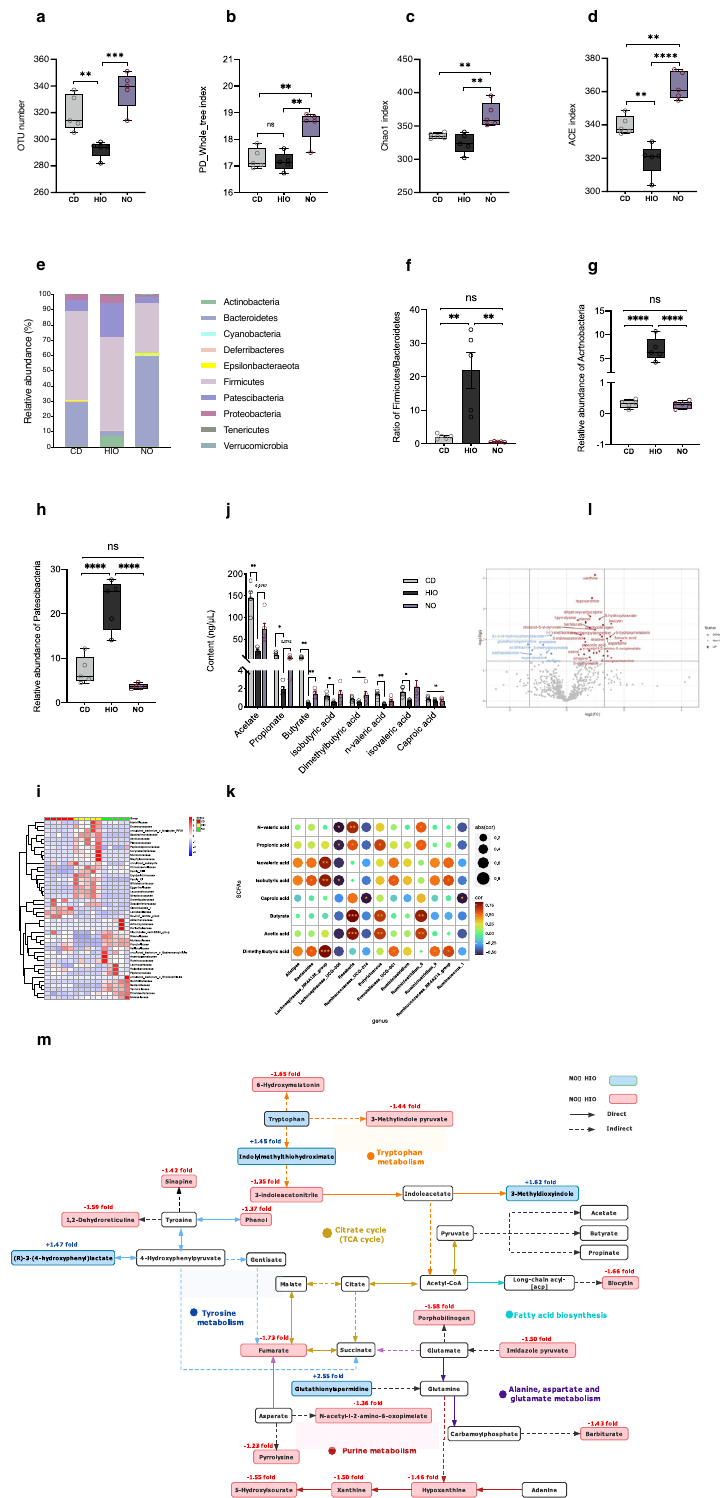
SCFA treatment ameliorates HFD obesity-induced bone loss To con fi rm whether microbiota impacts the bone parameters through SCFA production, we fi rst administrated a SCFA mix intragastrically to HIO mice. SCFAs improved the trabecular meshwork at the femoral head with relatively increased